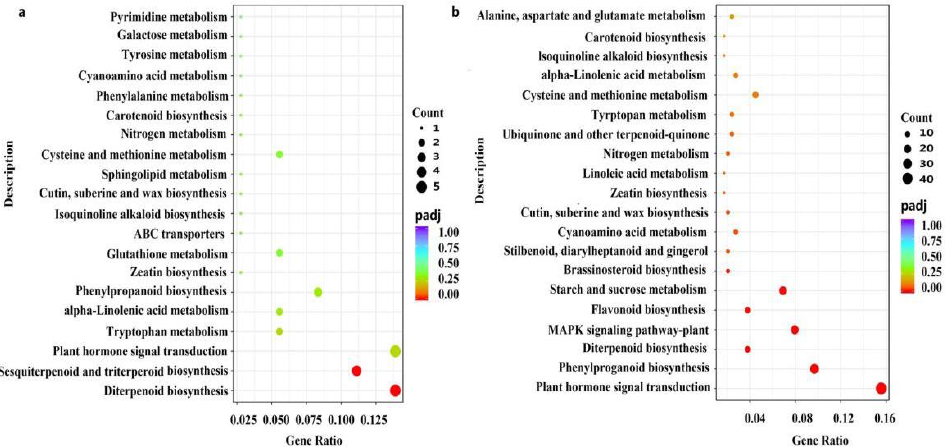
Figure 5. Pathway analysis based on Kyoto encyclopaedia of genes and genomes (KEGG) analysis. ( a ) The KEGG dot map of differentially expressed genes at 24 h after treatment. ( b ) The KEGG dot map of differentially expressed genes at 168 h after treatment.